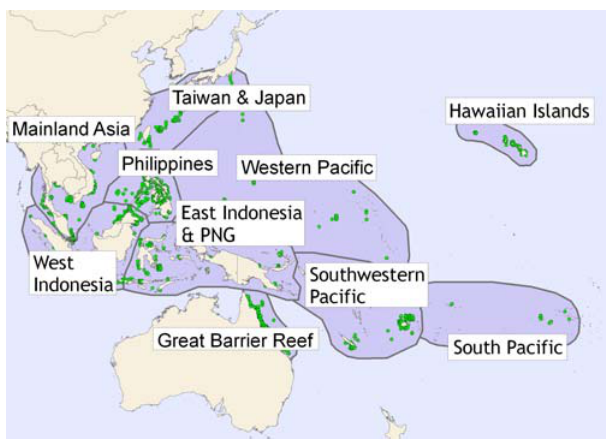
Figure 1. Map of study region, sub-regions, and the 2667 surveyed reefs (green